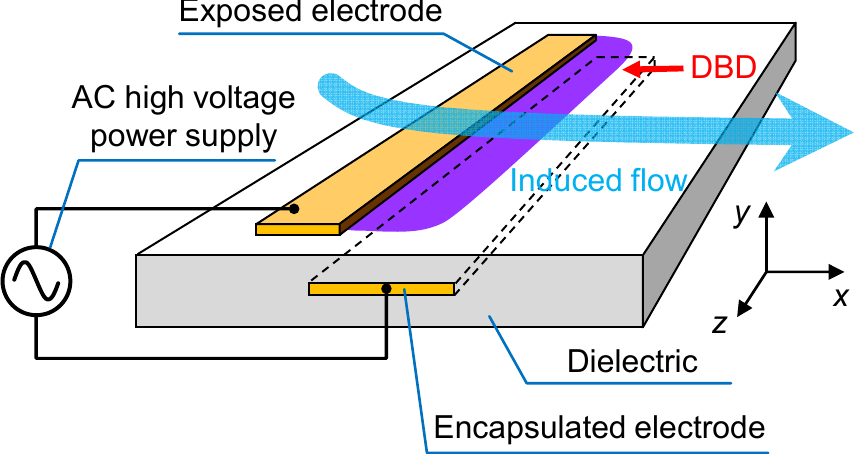
Figure 1. Schematic of conventional (sheet-type) PA originally proposed by Roth et al. [1]. On the other hand, when PAs are considered as fluid control devices, their mountability on the three-dimensional (3D) surfaces of fluidic systems is essential. When a sheet- type PA is attached to a 3D surface, wrinkles and steps develop which deteriorate the aerodynamic characteristics of the fluidic system. To solve these technical issues, string-type PAs (Figure 2a), which primarily comprise a conductive wire coated with a highly flexible insulation material, were proposed [7]. If a groove for embedding a metal wire is structured on the surface of the test piece, string-type PAs can be flush-mounted. As examples of active flow control utilizing string-type PAs, flow separation control on an airfoil [7] and a car door mirror model with half-cylindrical and quarter-spherical surfaces [8] have been experimentally demonstrated. String-type PAs are low cost, have high durability, and can be easily mounted onto 3D curved surfaces; these properties can be realized by utilizing conductive wires coated with silicone rubber. An additional advantage of string-type PAs is that the conductive wire is pre-insulated, except at both ends. This reduces the risk of short circuits caused by creep discharge. Furthermore, by grounding the exposed electrode and applying a high-voltage AC to the wire, electric shocks can be prevented during practical use, which significantly improves safety. However, the maximum induced flow velocity of string-type PAs is limited to ~2 m/s even when the applied voltage is increased [8]. Studies have suggested that this flow velocity limitation is caused by the wire diameter being similar to the width of the encapsulated electrode of sheet-type PAs. For example, Forte et al. investigated the effect of the width of an encapsulated electrode on the induced flow velocity in a conventional sheet-type PA and reported that the maximum flow velocity decreased with the width of the encapsulated electrode